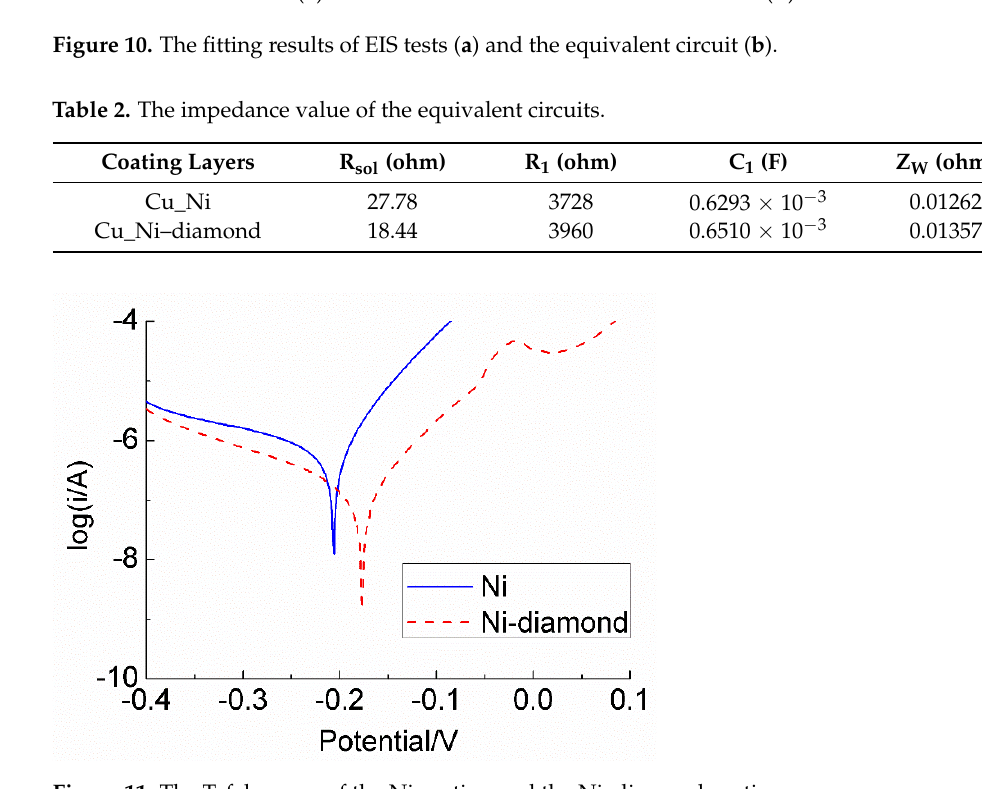
Figure 10. The fitting results of EIS tests ( a ) and the equivalent circuit ( b ). Table 2. The impedance value of the equivalent circuits.